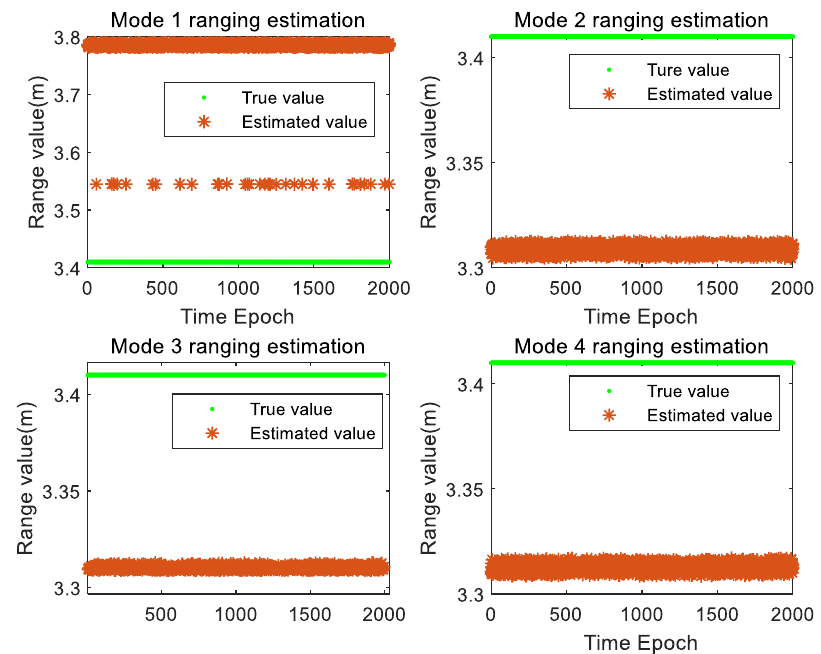
Figure 9. Ranging accuracy under different dual-frequency combination modes.